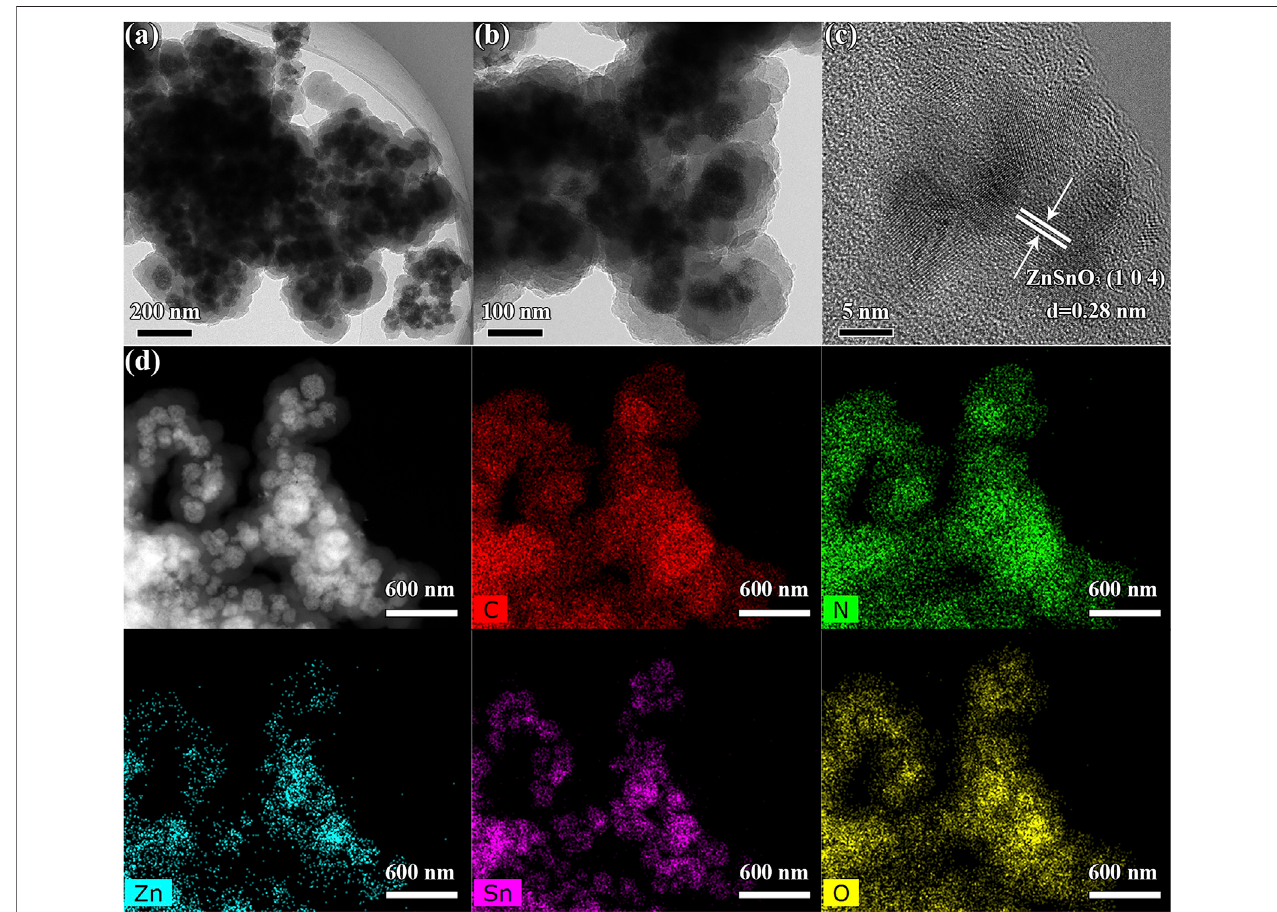
FIGURE 4 | TEM (A, B) and HRTEM (C) and EDS mapping (D) images of NC@ZSO-2.